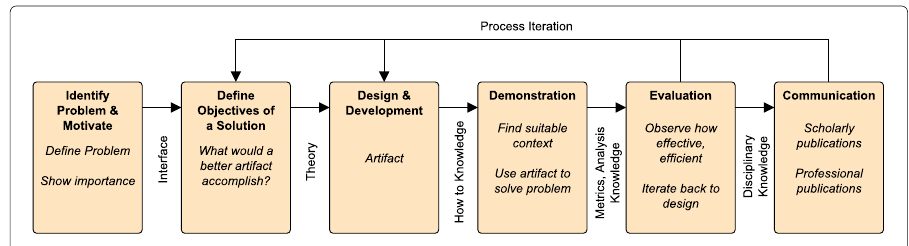
Fig. 1 Design Science Research process used for developing the EMSA framework (Peffers et al.